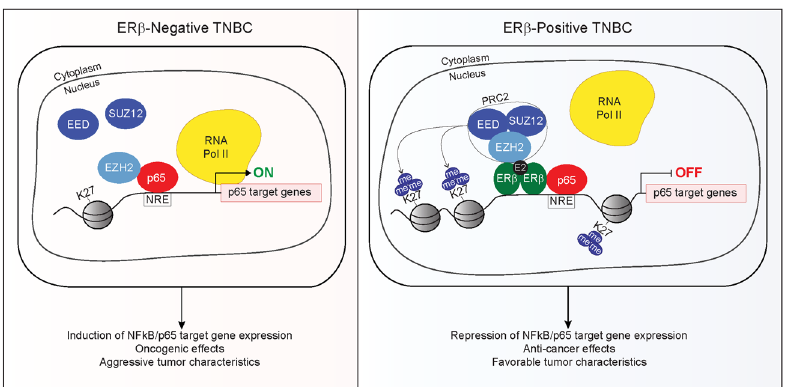
Fig. 6 Model. In ER β − TNBC cells (left), EZH2 associates with p65 in a PRC2-independent manner and functions to enhance p65 transcriptional activity and promote aggressive cancer phenotypes. In ER β + TNBC cells (right), ER β induces formation of a co-repressor complex involving p65, EZH2, and the PRC2 complex (including SUZ12, EED, and EZH2). This repressive complex results in trimethylation of H3K27, chromatin compaction, and subsequent blockade of NF κ B/p65 target gene expression, ultimately resulting in anti-cancer effects and less aggressive cancer